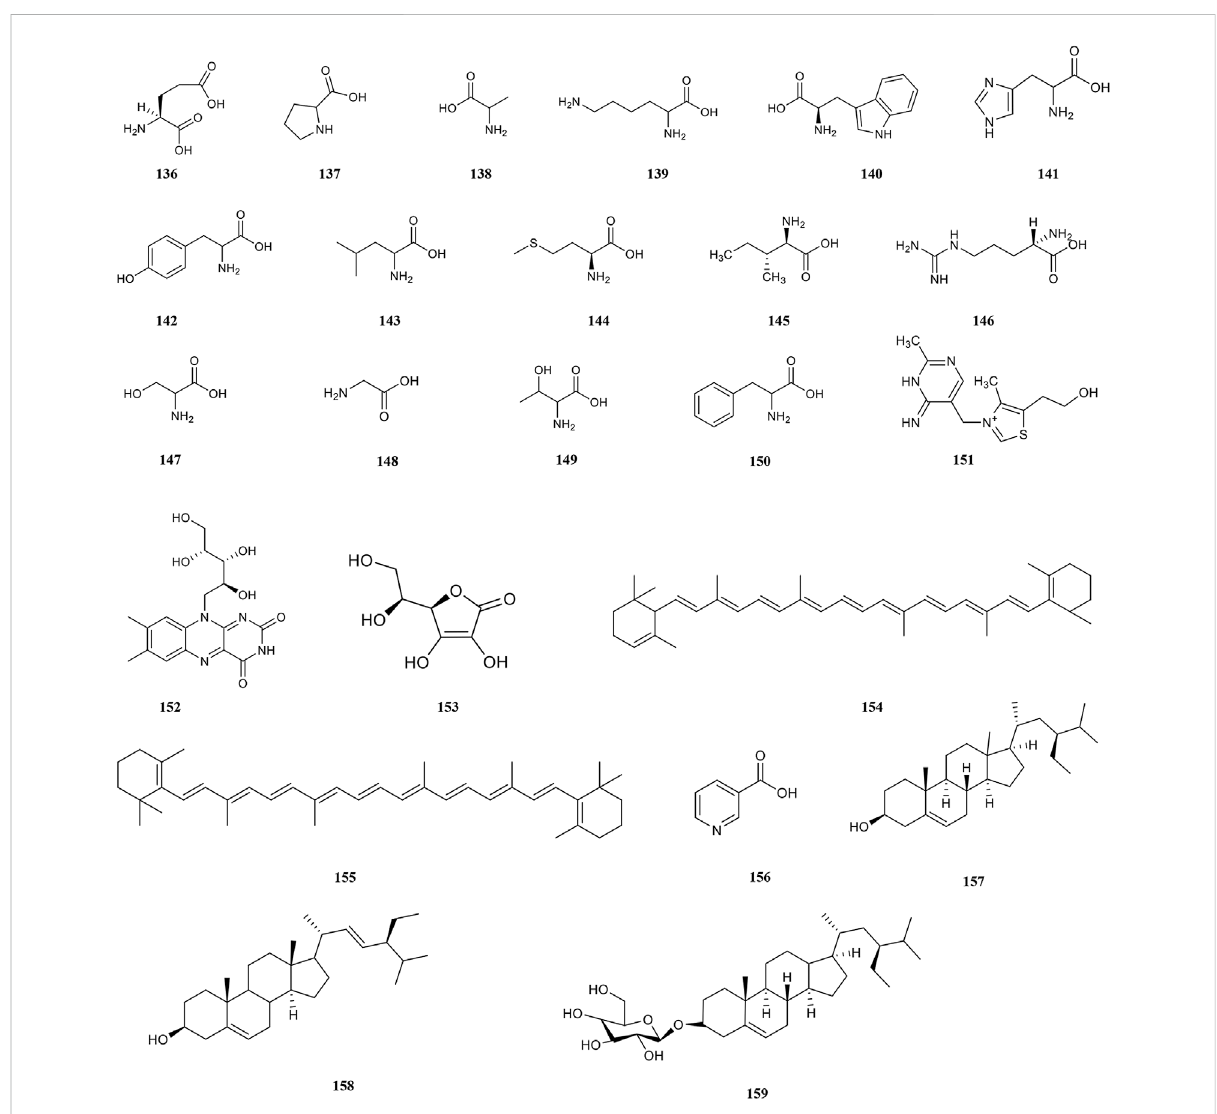
FIGURE 6 Chemical structures of amino acids, and other compounds (136 –